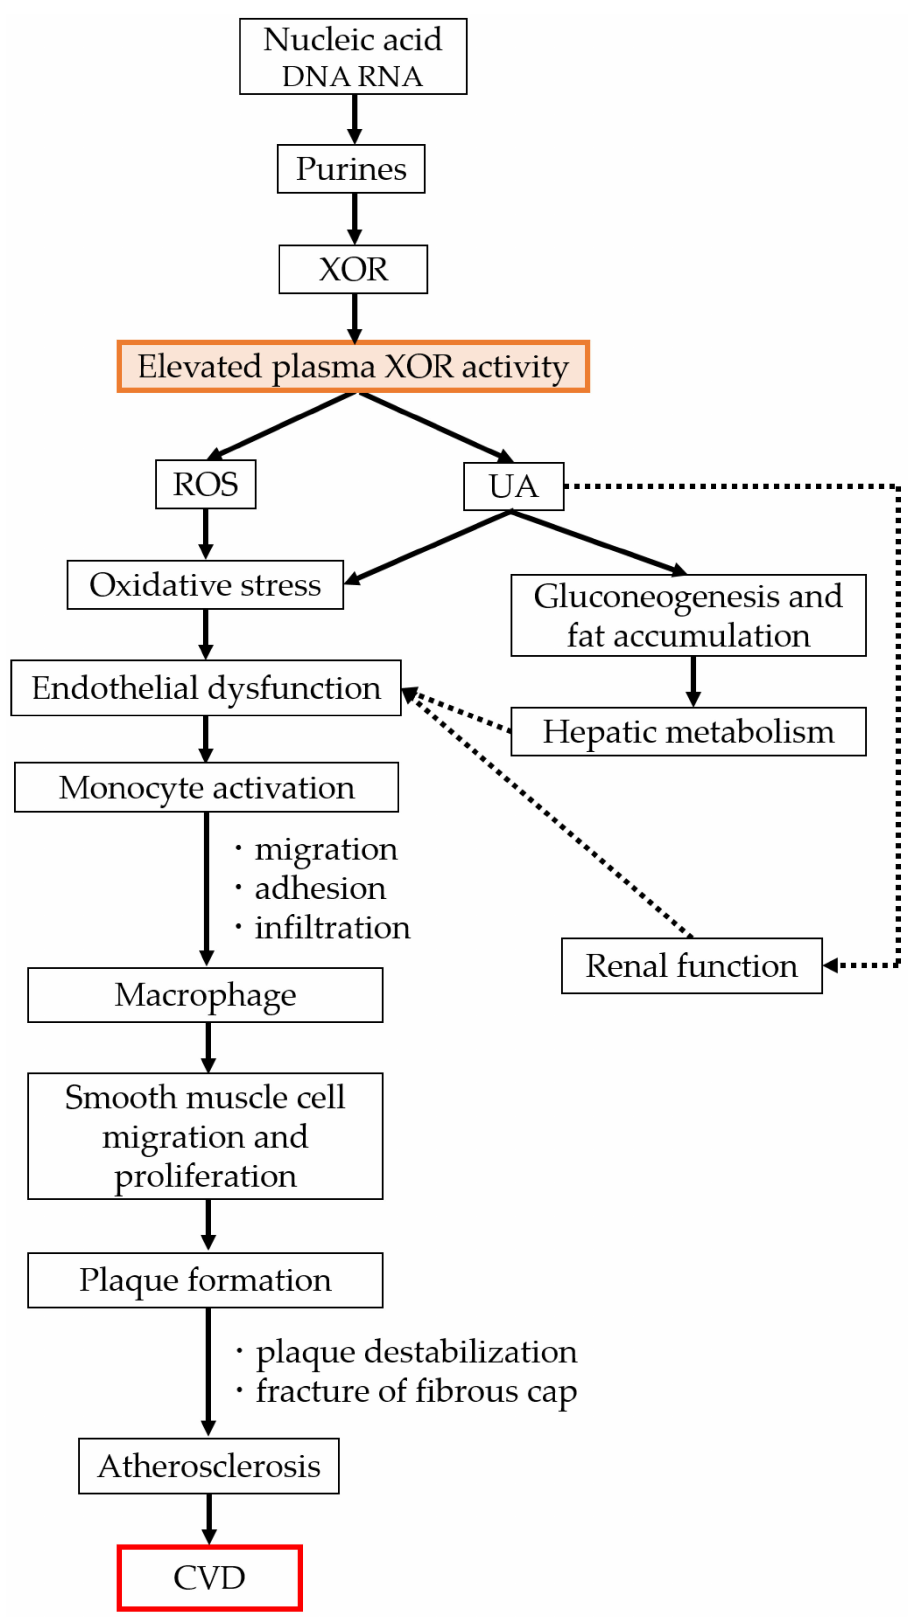
Figure 2. The relationship between plasma XOR activity and